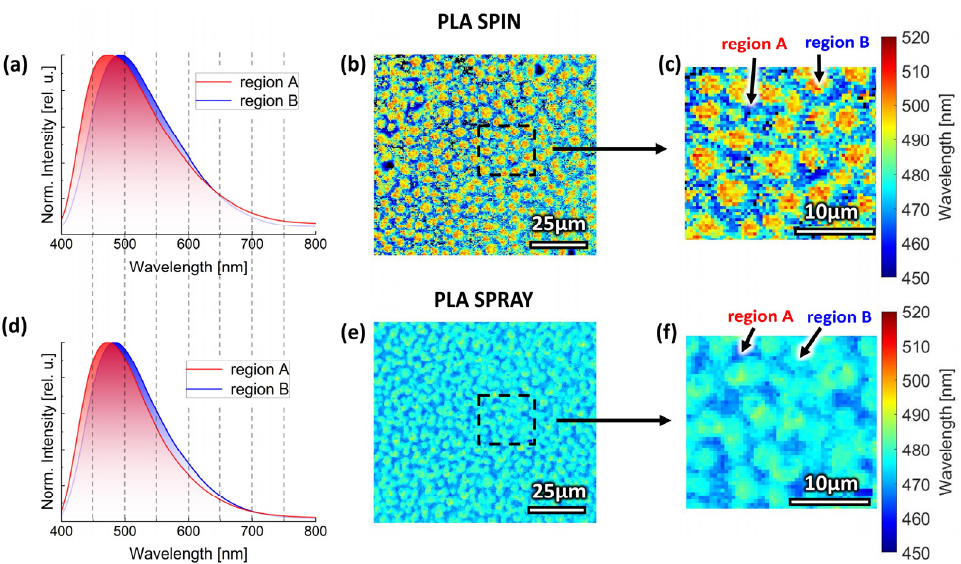
Figure 6. ( a , d ) Normalized PL spectra obtained by averaging an area of 50 × 50 µ m 2 of spin- and spray-coated PLA samples’ surface. ( b , e ) Map of the PL peak wavelength in each point of the image. ( c , f ) Zoom of the dashed areas, respectively shown in panels ( b , e ). Panels ( b , c , e , f ) are plotted with the same color scale.